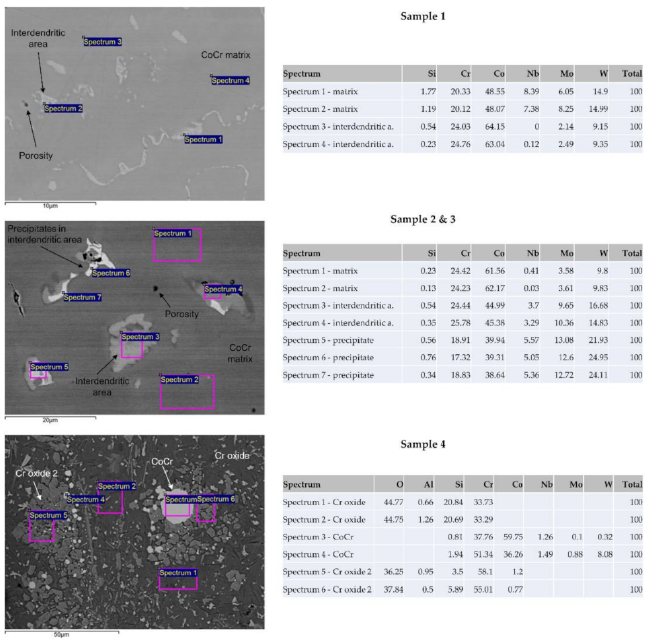
Figure 3. SEM with EDX analysis of all